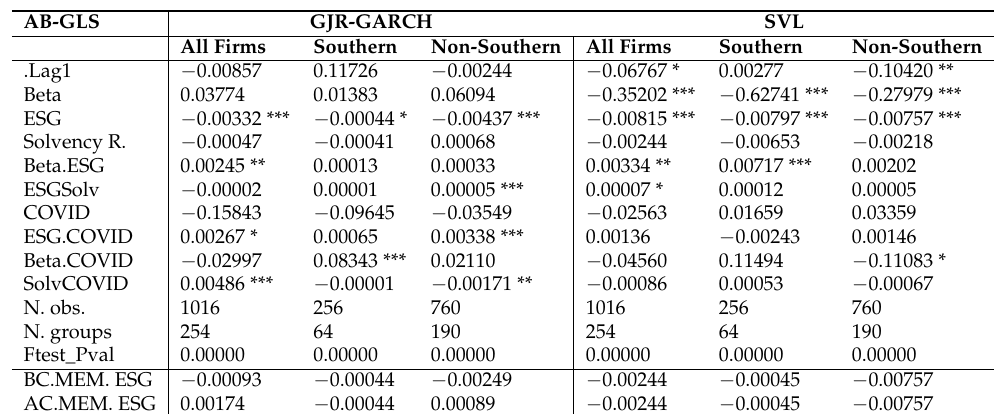
Table 6. AB-GLS estimation results for all models, Part